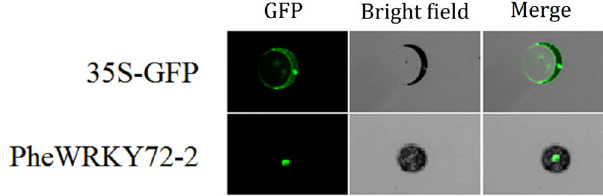
Figure 6. Subcellular localization analysis of PheWRKY72-2.